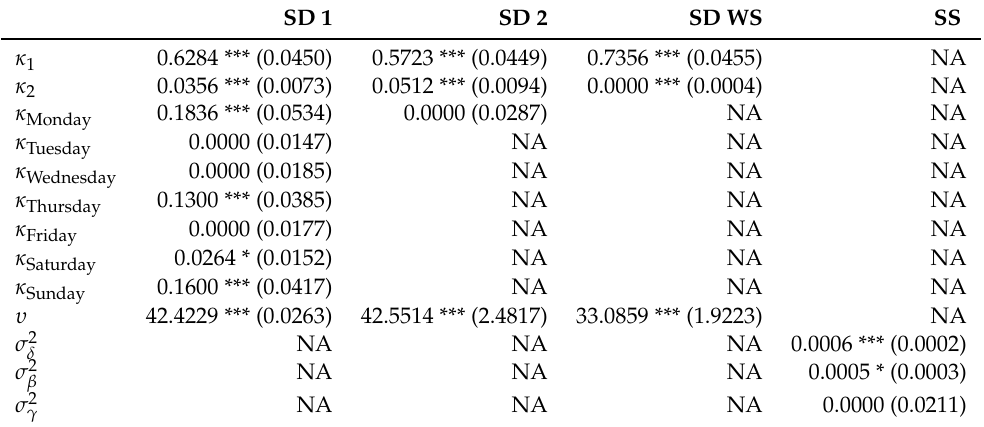
Table A5. Parameter estimates for Colombia.